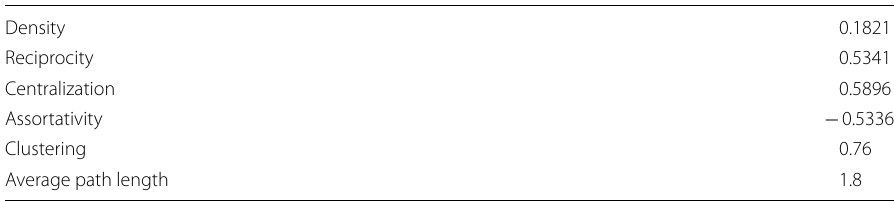
Source: Own elaboration with EORA